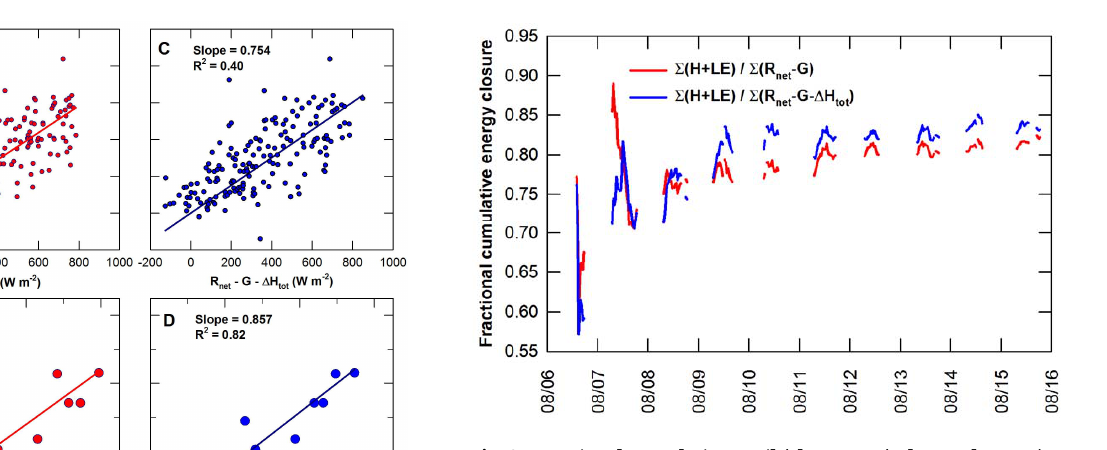
Fig. 9. Fractional cumulative available energy balance closure during the 10-day study period not including ( (H+ LE )/ (R net -G)) and including ( (H+ LE )/ (R net -G- H tot )) the total change in enthalpy in the water column ( H adv ) during daytime periods only.